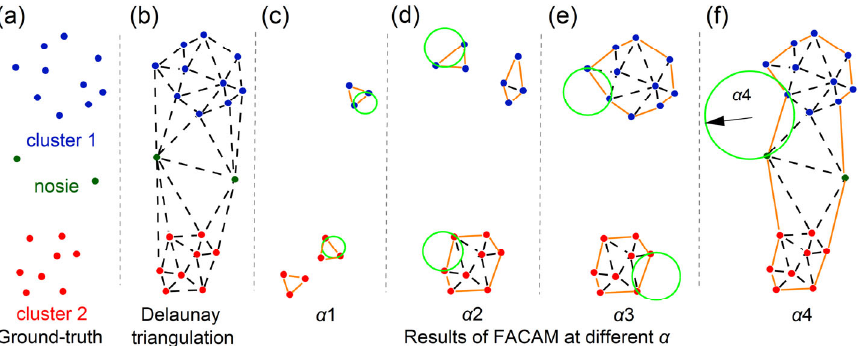
Figure 1. The working principle of FACAM. ( a ) A point set containing two clusters. ( b ) Construction of Delaunay triangulation for the point set in ( a ). ( c – f ) Clustering results of FACAM at different segmentation thresholds.